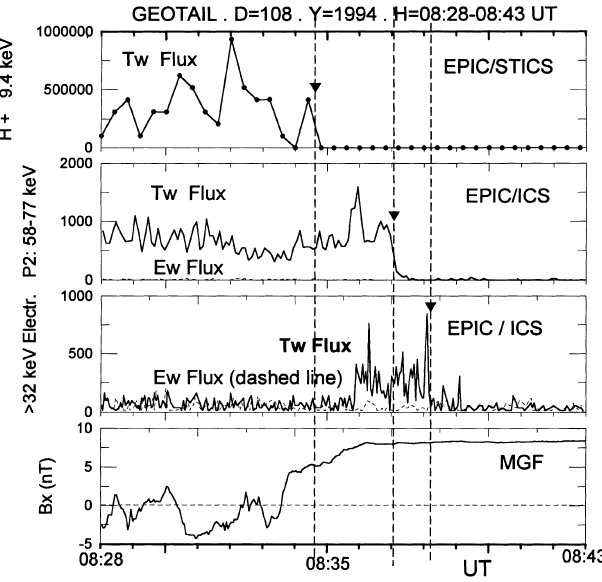
Fig. 10. GEOTAIL exits the plasma sheet to the north lobe magnetic field structure ( bottom panel ) and detects a clear reverse velocity dispersion e(cid:128)ect. First the lower-energy protons disappear ( (cid:24) 9.4 keV, first panel ) and finally the >32-keV energetic electrons ( third panel ). The dominant flux is the tailward ( solid thick